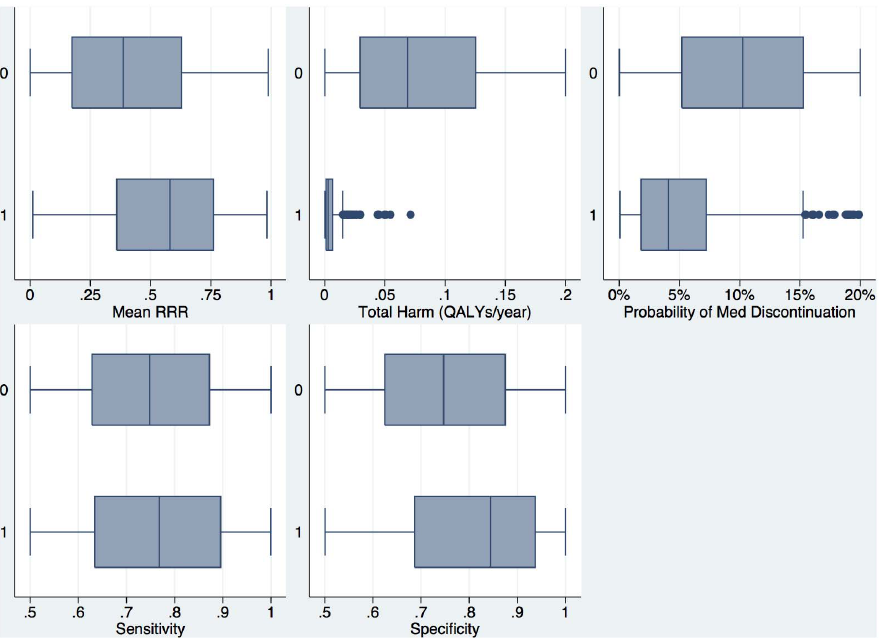
Figure 6. Multi-way sensitivity analysis: Distribution of Intervention Parameters in Beneficial vs. Non- beneficial trials. Box plots of the distribution of intervention parameters across the range of parameters studied. X-axis for each individual plot represents the range of parameter values. Total harm represents the combination of the probability and magnitude of harm in average total QALYs/year lost to harm in treated patients. This parameter was truncated at a value of 0.2 (one QALY lost for every five patient-years) so that the distribution in beneficial trials could be more clearly seen.